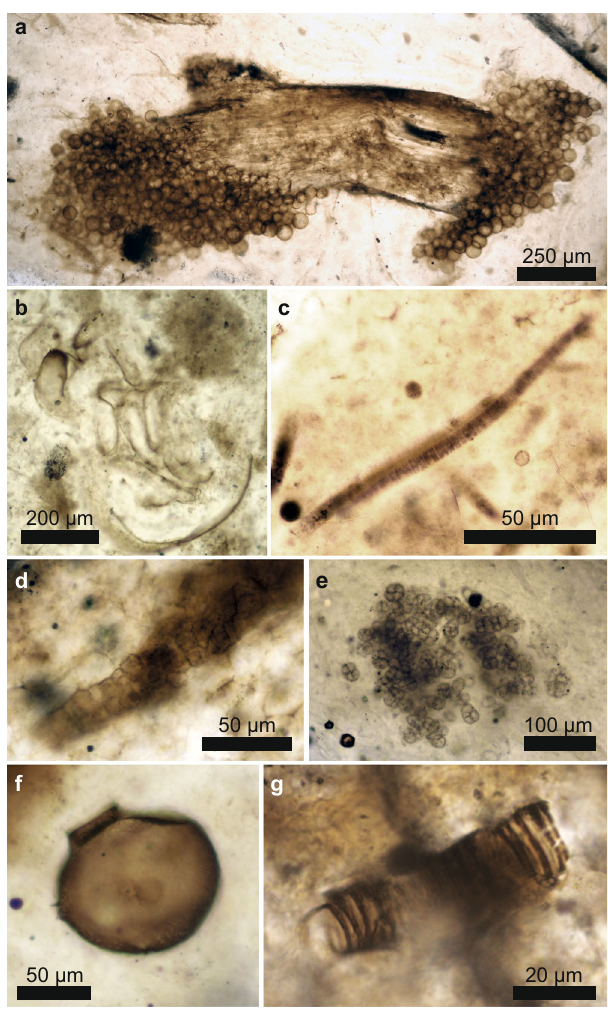
Fig. 1 | Rhynie chert fossils. Photomicrographs of representative Rhynie chert eukaryotic ( a , b , f , g ) and prokaryotic ( c – e ) groups of organisms. Palaeomyces sp. (fungi) on plant stalk ( a );Arthropod ( b ); Palaeolyngbya kerpii (cyanobacterium, c ); Stigonema-like cyanobacteria ( d ); Rhyniosarcina devonica (cyanobacterium, e ); Palaeoleptochlamys hassii (putative arcellinid amoeba, f ); Nematoplexus rhyniensis (nematophyte, g ). Photomicrographs were taken by ER, SM, and CCL at the Uni- versity of